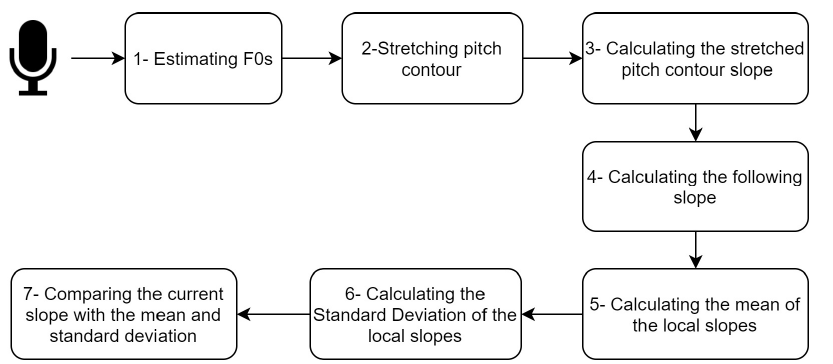
Figure 1. The main steps to find onsets in the proposed algorithm.